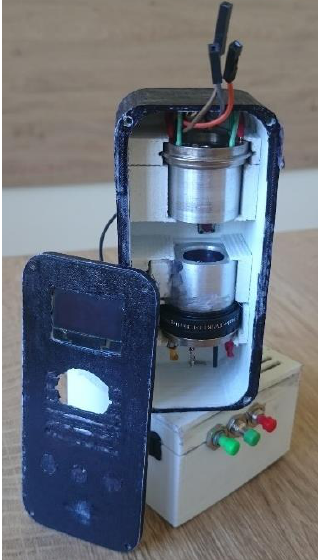
Fig. 3. The non-invasive optical glucometer prototype with the ellipsoidal